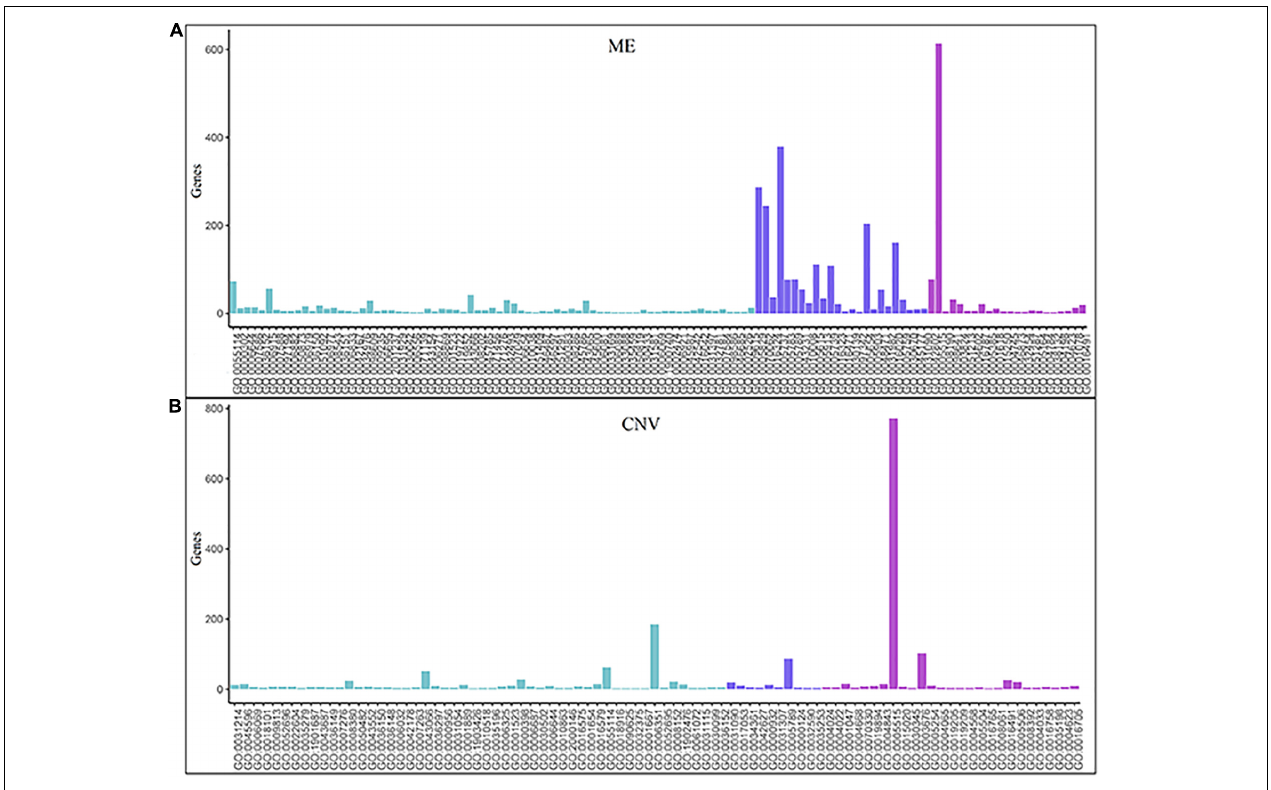
FIGURE 4 | Numbers of enriched genes in GO terms obtained from enrichment analyses of ME and CNV core modules identified by the NMFNA. (A) Represents numbers of the enriched gene of the ME core module and (B) represents numbers of the enriched gene of the CNV core module. TABLE 2 | Details of significant GO terms obtained from enrichment analyses of ME and CNV core modules identified by the NMFNA. adj.P is the p -value corrected by the FDR.